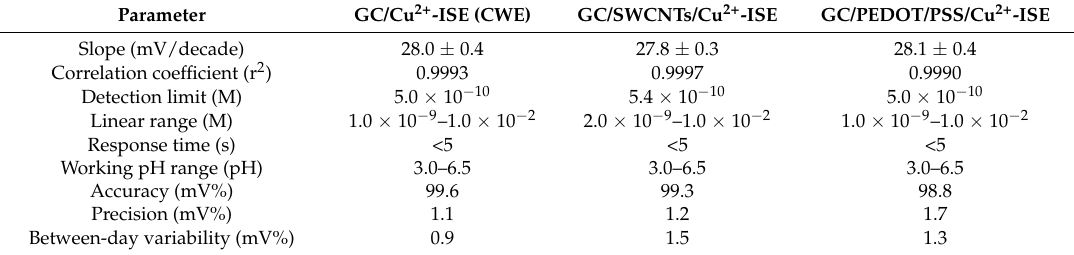
Table 1. Response characteristics of solid contact-Cu 2+ -ISEs.